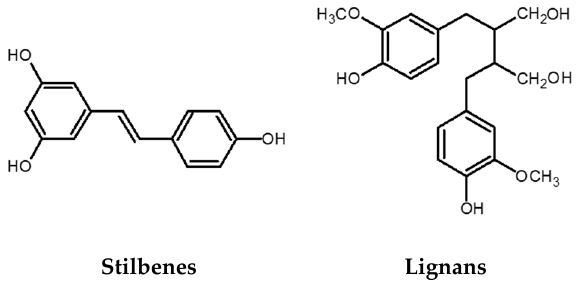
Figure 3. Chemical structures of stilbenes and lignans.